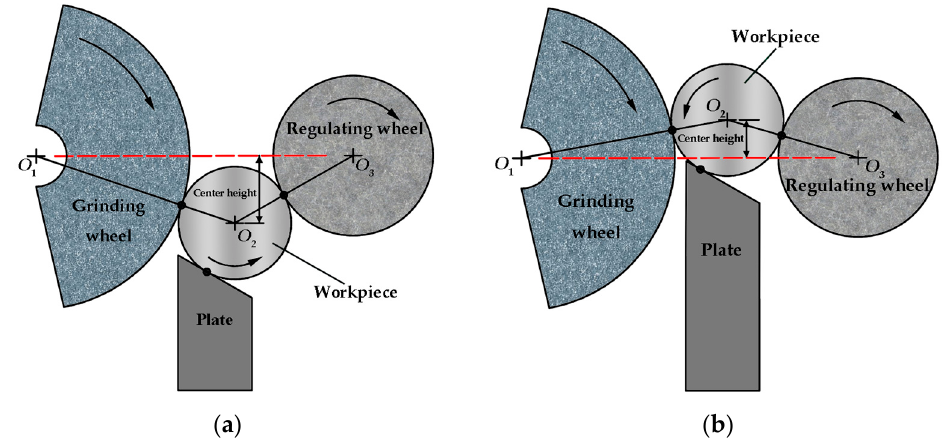
Figure 4. Influence mechanism of center height on profile shape: ( a ) the center height is negative, and the center of the workpiece is lower than the center line of the grinding wheel and the regulating wheel; ( b ) the center height is positive, and the center of the workpiece is higher than the center line of the grinding wheel and the regulating wheel.